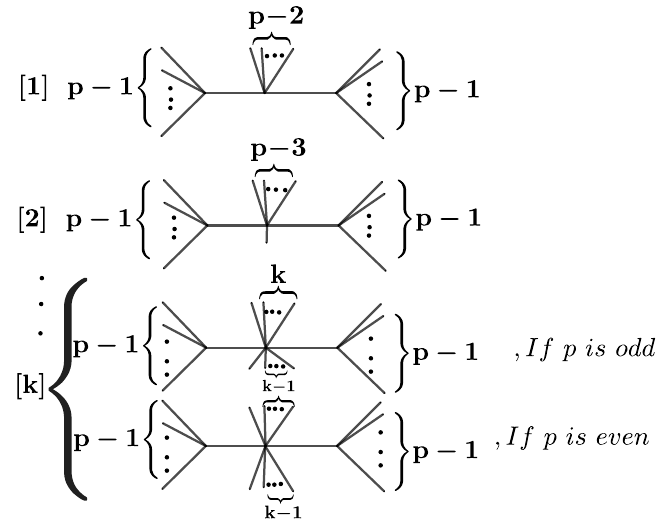
Figure 6 . The primitive graphs for n = 2